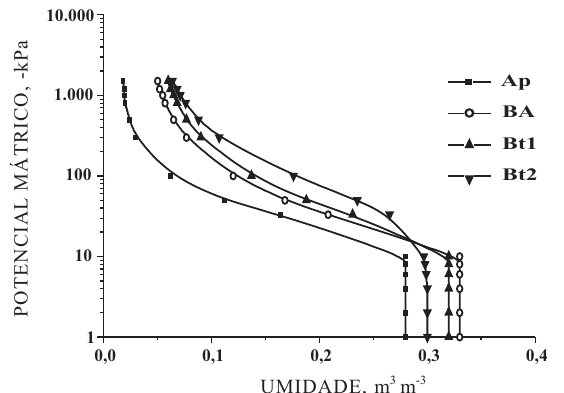
Figura 3. Curvas características de umidade do Argissolo Vermelho distrófico